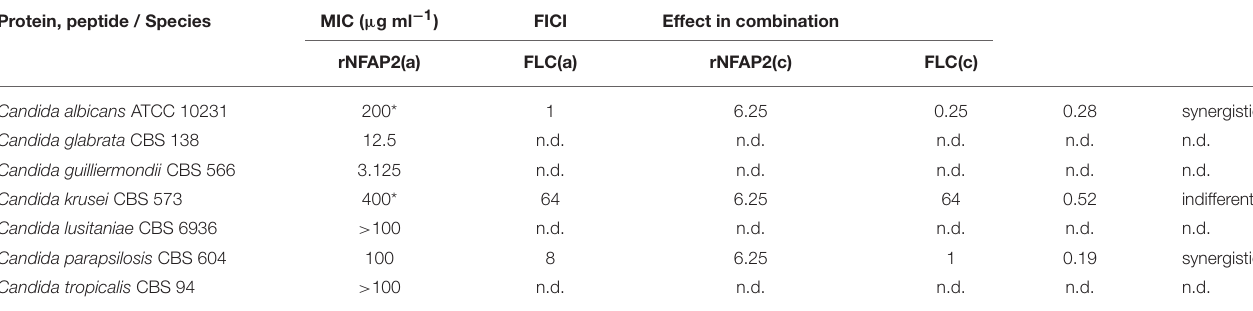
TABLE 3 | Minimal inhibitory concentrations of rNFAP2 and FLC, and their combination in RPMI 1640 after incubation for 48h at 35 ◦ C. Protein, peptide / Species MIC ( µ g ml − 1 ) FICI Effect in combination rNFAP2(a) FLC(a) rNFAP2(c) FLC(c)